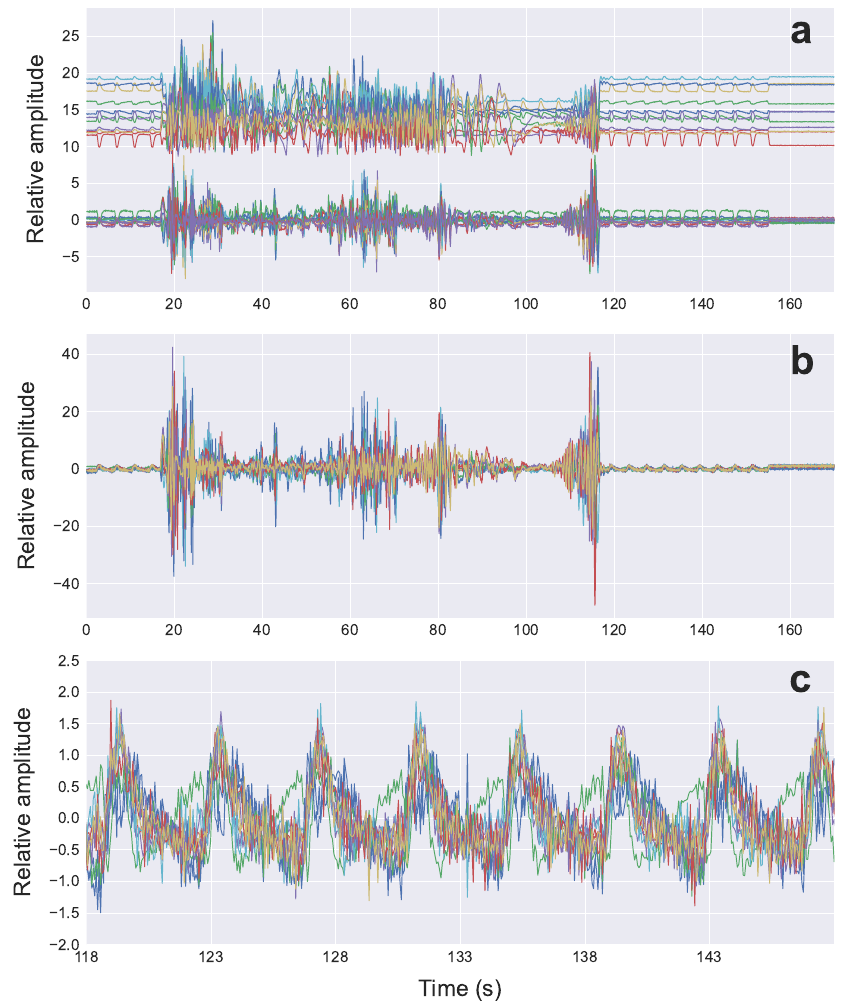
Figure 9. Raw RB-ANN filtered radar signals from 11 target range bins measured for a sinusoidal breathing pattern simulated by the RMP during VMAT treatment delivery ( a ). Each colored line represents the signal from one of the 11 range bins. Shown also are the weighted and polarity inverted signals for the entire duration of data collection ( b ) and for the interval between 110 s and 150 s ( c